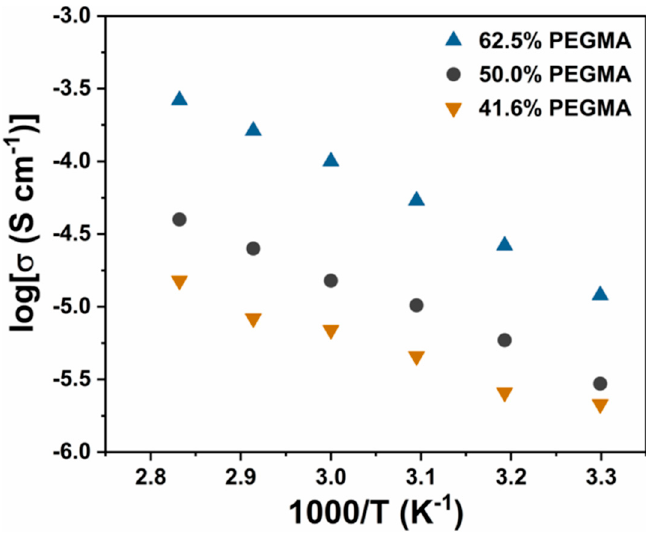
Figure 6. Ionic conductivity of P(EO-PEGMA)/PVDF polymer electrolyte with different P(EO- PEGMA) content.